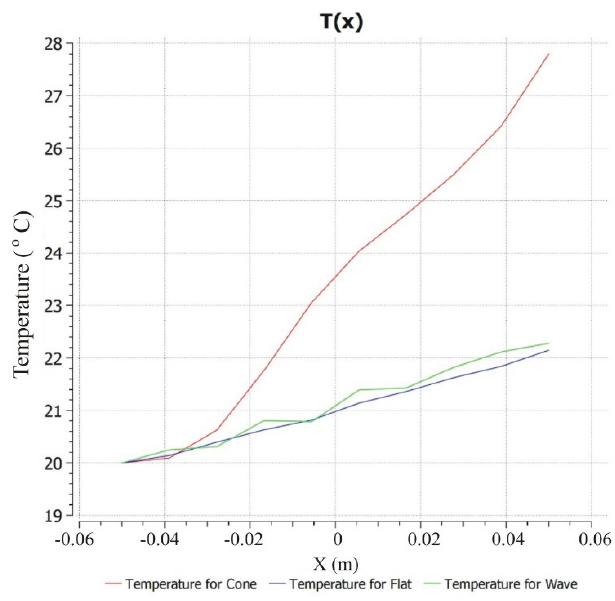
Figure 11. Temperature change: red—plate with conical stamping; blue—flat heat exchange plate; green—chevron heat exchange plate.